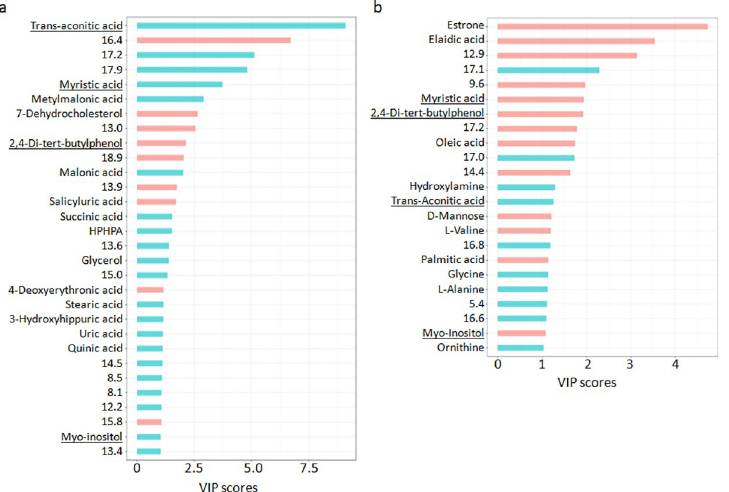
Fig 2. Contribution of metabolites in the separation of AVS cases and controls. The Variable Importance in Projection (VIP) was used to weigh the contribution of urine (a) and plasma (b) metabolomic features to the separation between cases and controls in the PLS-DA model. Data were normalized to the internal standard 2-isopropylmalic acid. Upregulated (blue bars) and downregulated (red bars) features are shown. Metabolites found associated with AVS in both urine and plasma are underlined. Details of metabolite features are given in S3 Table